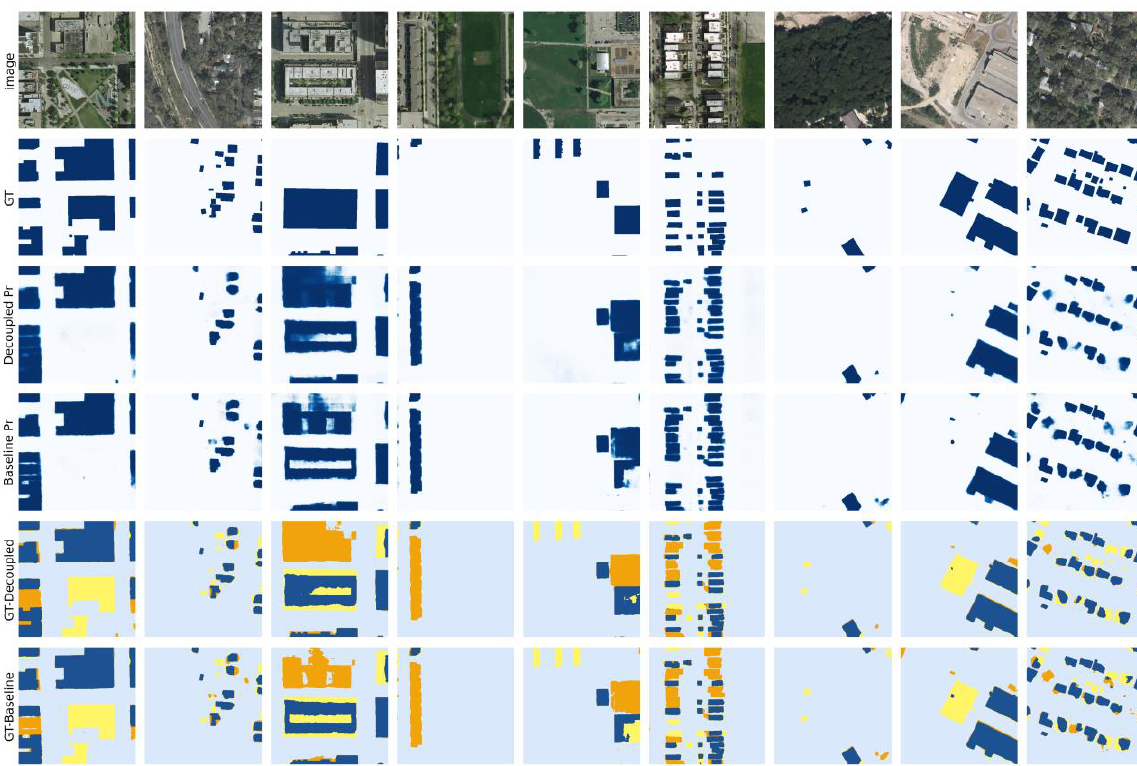
Figure 8. Examples of poor ground truth building